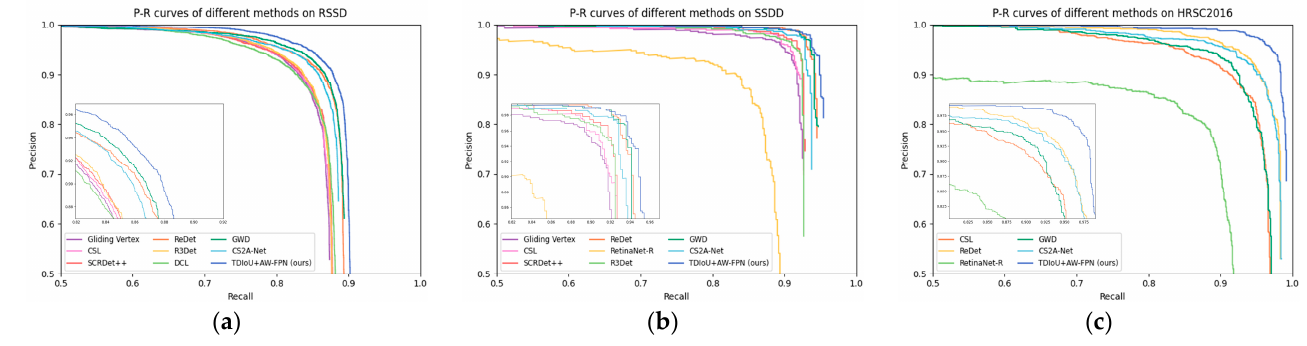
Figure 27. P–R curves of different methods on ( a ) RSSD, ( b ) SSDD and ( c ) HRSC2016.